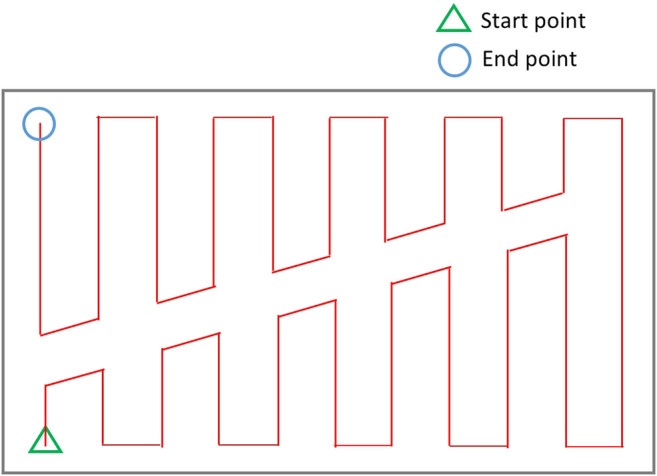
Coverage of a single cell in (Mannadiar and Rekleitis, 2010).